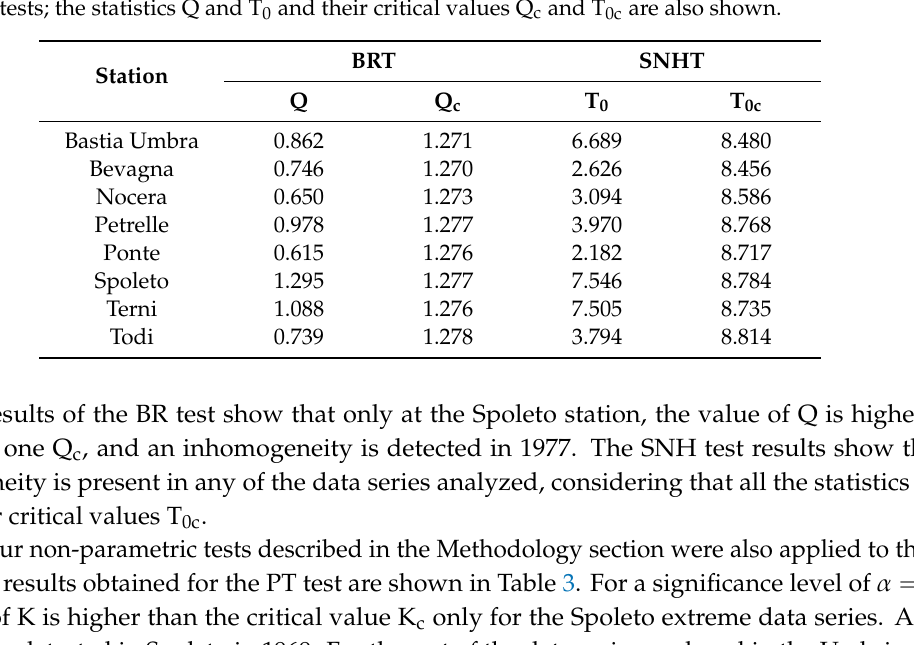
Table 3. Results obtained after applying the Pettitt test. Station